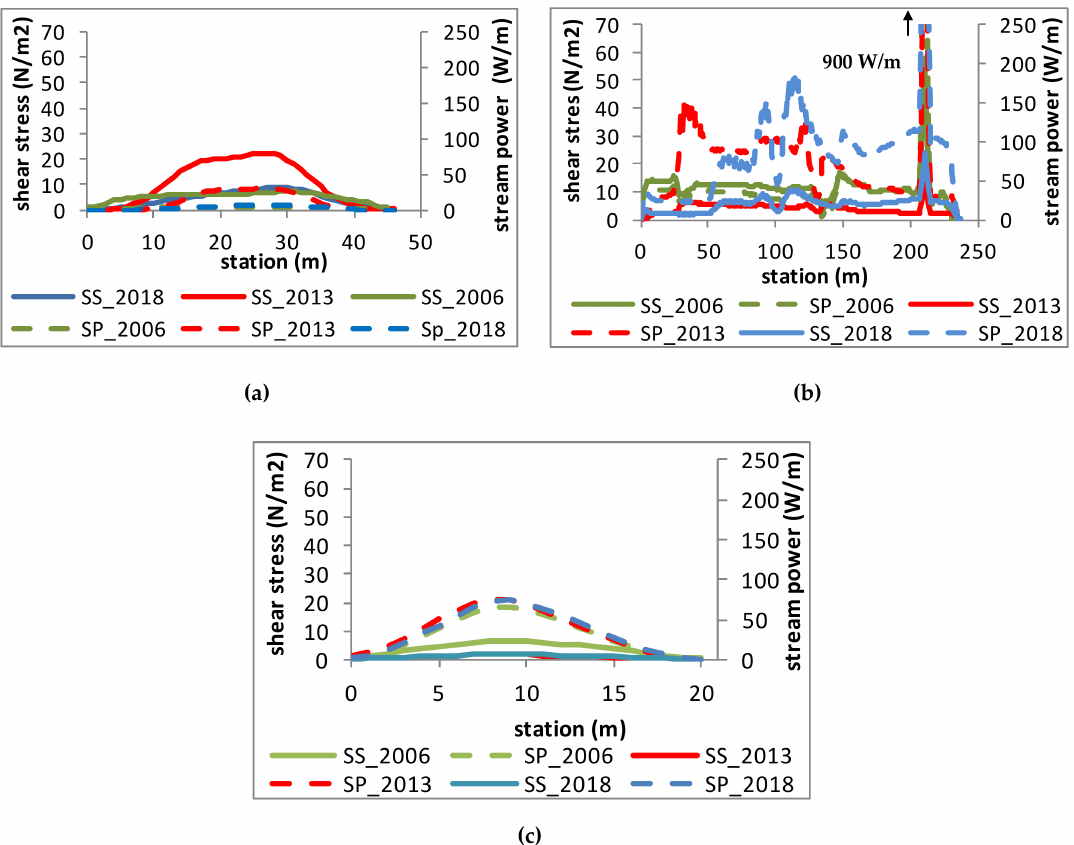
Figure 13. Shear stress and stream power in chosen cross-section: ( a ) inlet; ( b ) internal dam; ( c )